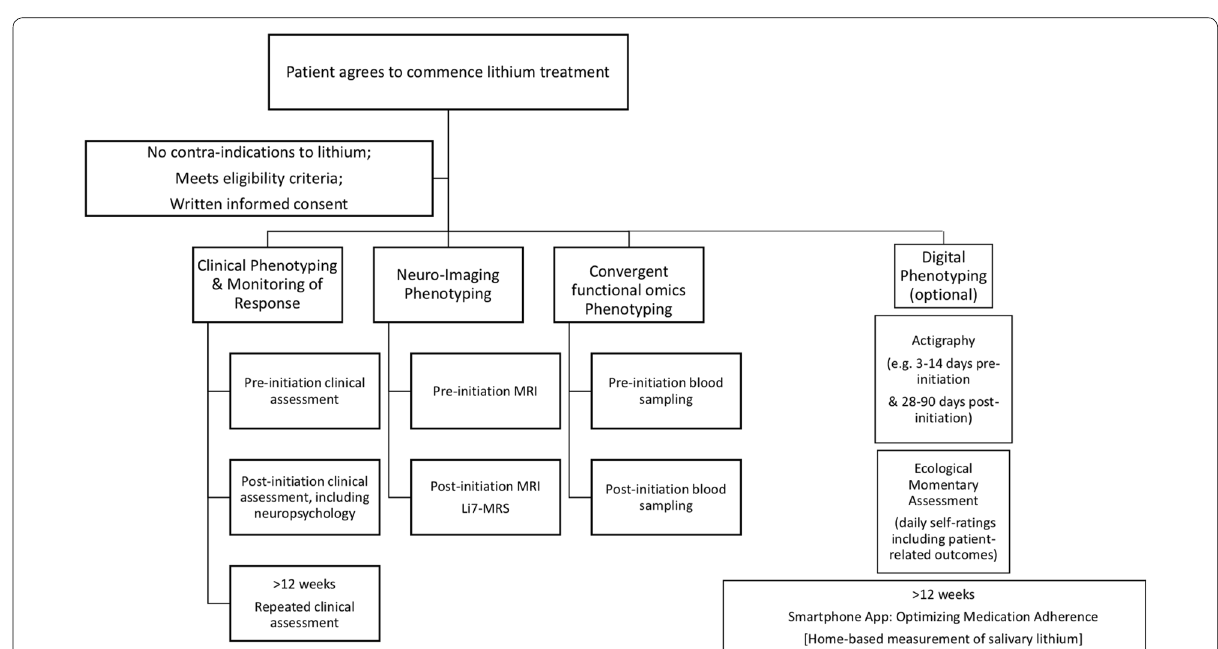
Fig. 1 Sequence of assessment of clinical, structural, functional and metabolic markers (see text for details). Pre‑initiation refers to the time period between agreement to commence a trial of lithium and actual initiation of medication, and it is expected to average about 2 weeks; most post‑initiation measures will be undertaken at approximately week 12 (allowing for titration of lithium dosage & stabilization of plasma levels); neuropsychology assessment will be undertaken in individuals with 4 consecutive weeks of euthymia; actigraphy will ideally be include some days pre‑lithium initiation, as some analyses will be feasible with a minimum of 3 days of continuous recording; post‑lithium initiation actigraphy may be extended for prolonged periods in patients who consent to this; any program for optimizing adherence will commence after approximately 12 weeks (after stabilization of lithium treatment), when repeated ratings of levels of adherence are available; home‑based salivary lithium assessments will only be undertaken in a small subsample of patients who agree to participate in an exploratory pilot study (during the second year of